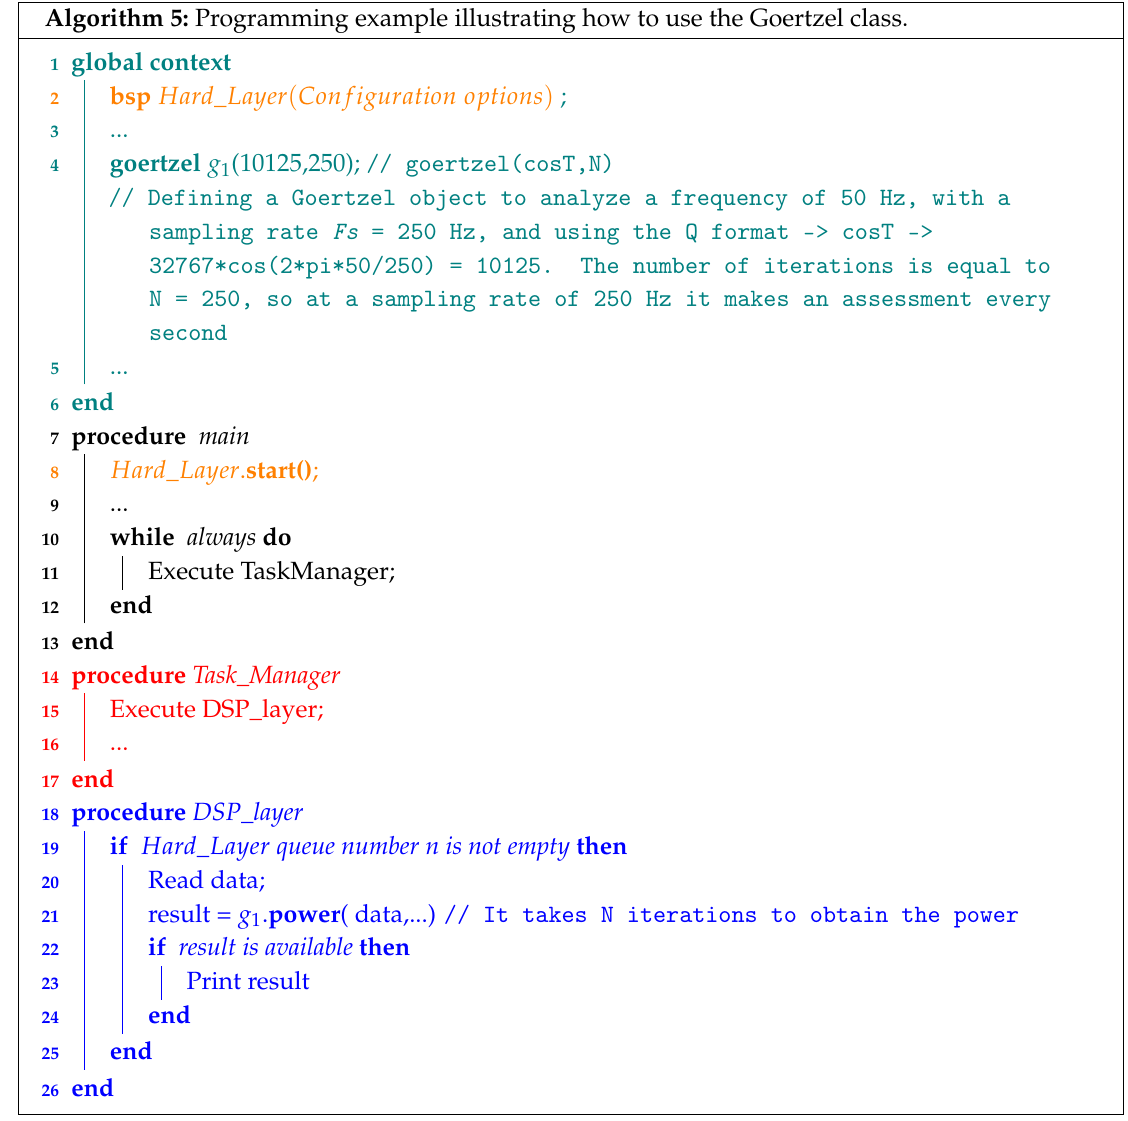
Algorithm 5: Programming example illustrating how to use the Goertzel